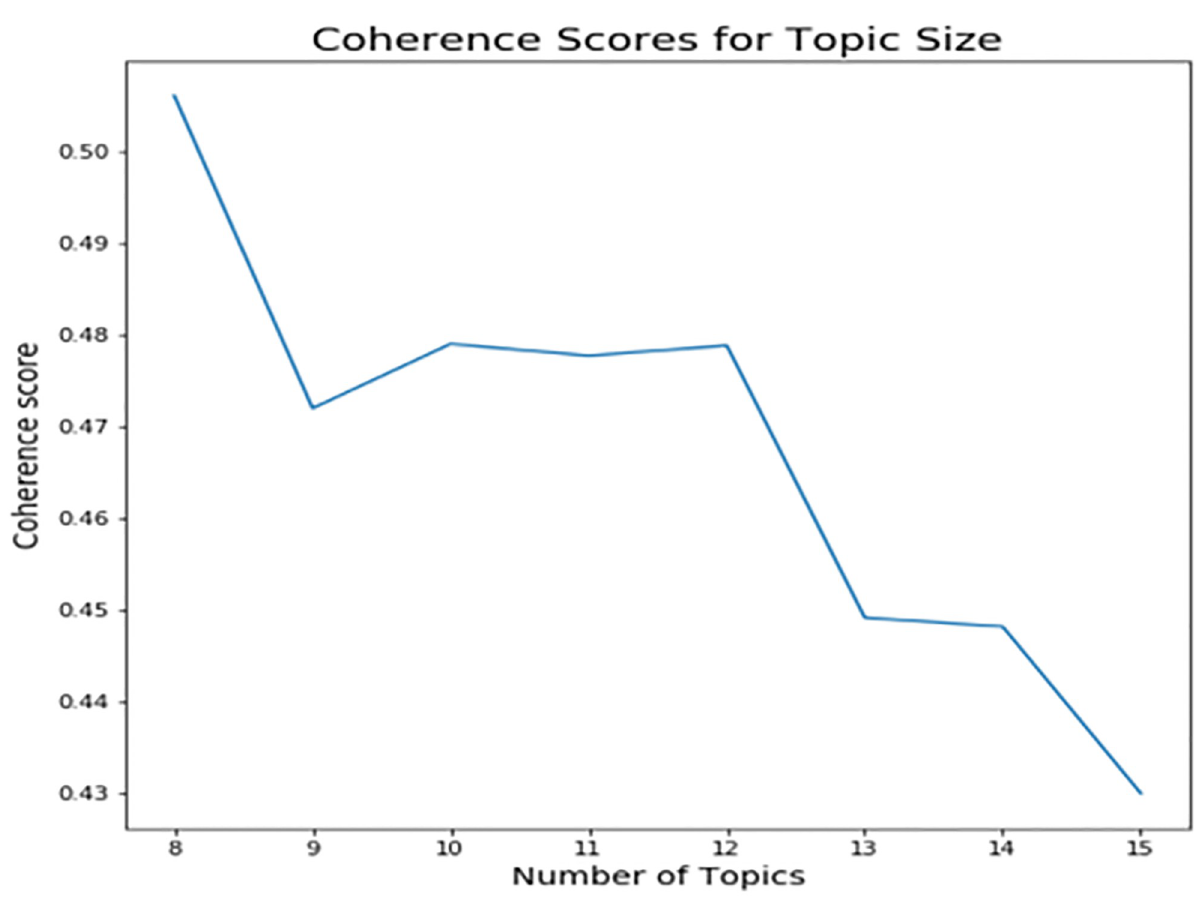
Fig 1. Coherence score for US job posting